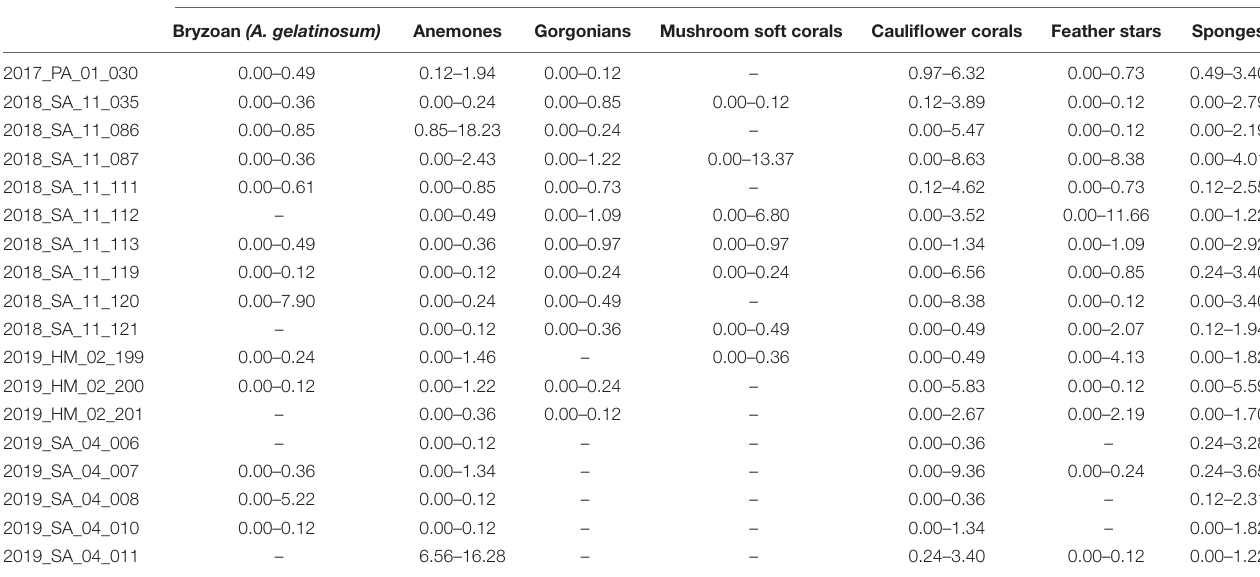
TABLE 5 | The minimum and maximum (min-max) densities (individuals or colonies m − 2 ) of taxa observed within a single image for each station, based on the number of annotations adjusted for the area of the field of view in the image (8.23 m 2 ).